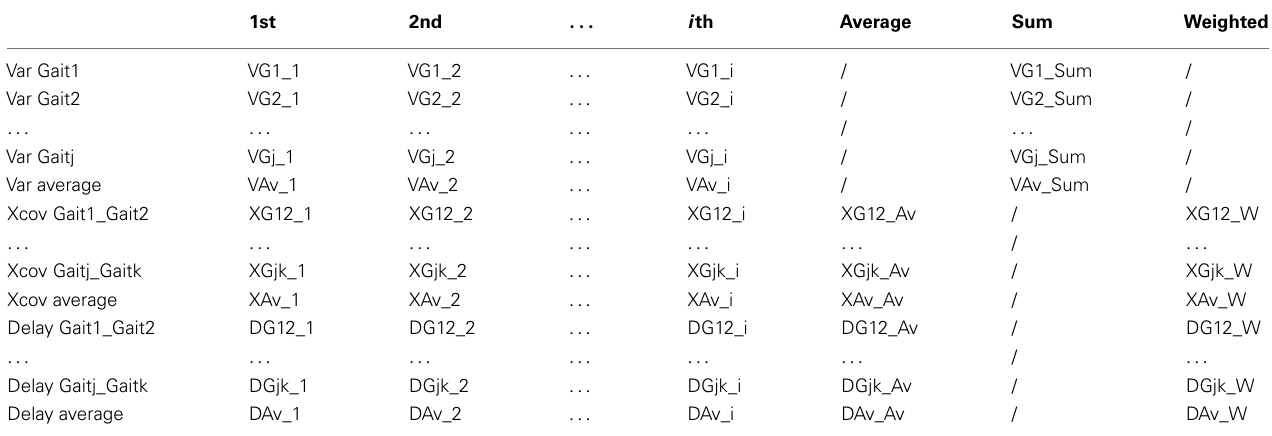
Table 1 | Generic table schema for the report of